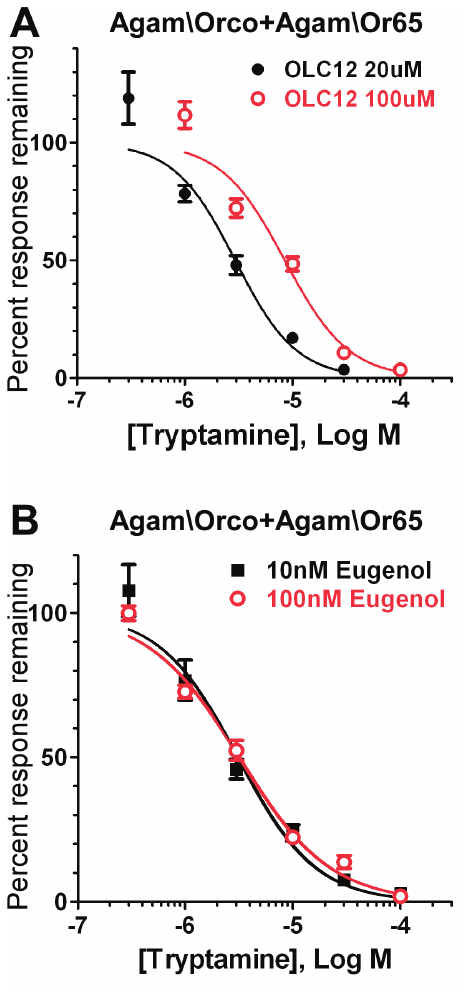
Figure 5. Tryptamine antagonism of odorant activation of an Agam\OR is non-competitive. A ) Tryptamine competitively inhibits OLC12 activation of Agam\Orco+Agam\Or65. Altering the concentration of Orco agonist (OLC12) shifts the tryptamine inhibition curve. The IC for tryptamine inhibition of Agam\Orco+Agam\Or65 50 activation by 20µM OLC12 (2.9 ± 0.5µM, n = 3) is significantly different (p<0.0001, F-test) from the IC for tryptamine inhibition of 50 Agam\Orco+Agam\Or65 activation by 100µM OLC12 (8.5 ± 1.1µM, Figure 4. Tryptamine and tyramine inhibit odorant activation of n = 3). B ) Tryptamine non-competitively inhibits odorant activation of ORs from different insect species. A ) Oocytes expressing Orco Agam\Orco+Agam\Or65. Altering odorant (eugenol) concentration from each of three different species were activated by the indicated fails to shift the tryptamine inhibition curve. The IC values for 50 concentration of OLC12. For Cqui\Orco from Cx. quinquefasciatus , tryptamine inhibition of responses to 10nM eugenol (3.1 ± 0.4µM, 30µM is the ~EC ; for Agam\Orco from An. gambiae , 30µM is the ~EC ; n = 4), and 100nM eugenol (3.2 ± 0.3µM, n = 3) did not differ 5 3 . Current for Dmel\Orco from D. melanogaster , 20µM is the ~EC (p=0.7172, F-test). 10 responses in the presence of 10µM tryptamine were compared to the average of two preceding responses to OLC12 and are presented Initial analysis of electrophysiological data was done using Clamp- as mean ± SEM (n = 4-9). B – C ) Tryptamine and tyramine inhibit fit 9.1 software (Molecular Devices). Curve fitting and statistical odorant activation of heteromeric ORs from different insect species. analyses were done using Prism 5 (Graphpad). Concentration- Oocytes expressing an OR from An. gambiae (Agam\Orco+Agam\ Or65) were activated by 100nM eugenol, oocytes expressing an inhibition data were fit to the equation: I = I /(1+ (X/IC ) n ) where max 50 OR from O. nubilalis (Onub\Orco+Onub\Or6) were activated by I represents the current response at a given concentration of inhibitor, 1µM Z11-14:OAc, oocytes expressing an OR from M. caryae (Mcar\ X; I is the maximal response in the absence of inhibitor; IC is Orco+Mcar\Or5) were activated by 150µM 2-phenylethanol. Current max 50 the concentration of inhibitor present that still allows a half maximal responses in the presence of 10µM tryptamine ( B ) or 100µM tyramine response from odorant; n is the apparent Hill coefficient. Concen- ( C ) were compared to the preceding response to odorant alone and tration-response data were fit to the equation: I = I /(1+(EC /X) n are presented as mean ± SEM (n = 3). max 50